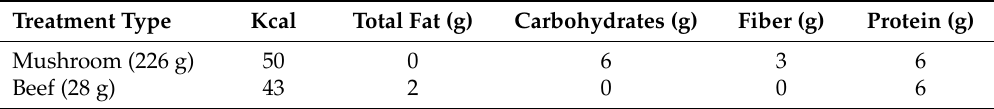
Table 2. Nutrition composition of each serving of mushrooms and meat provided for ten-day food intake assessment.